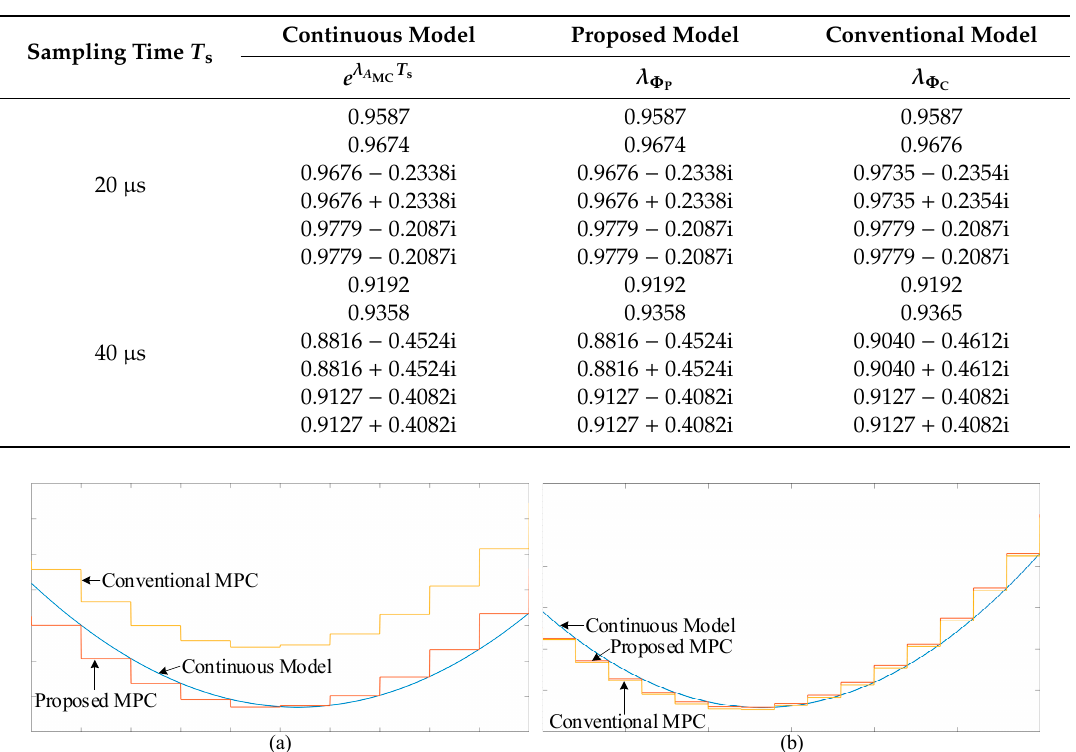
Table 2. Eigenvalues of matrices A MC , Φ P , and Φ C.